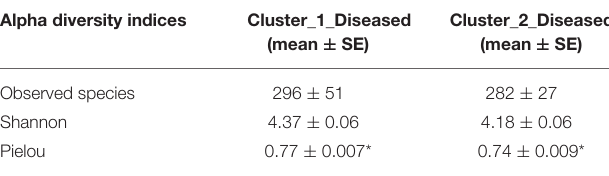
TABLE 1 | Comparisons of richness (observed species), diversity (Shannon), and evenness (Pielou) of two clustered oropharyngeal (OP) microbiotas in H7N9 patients (i.e., Cluster_1_Diseased and